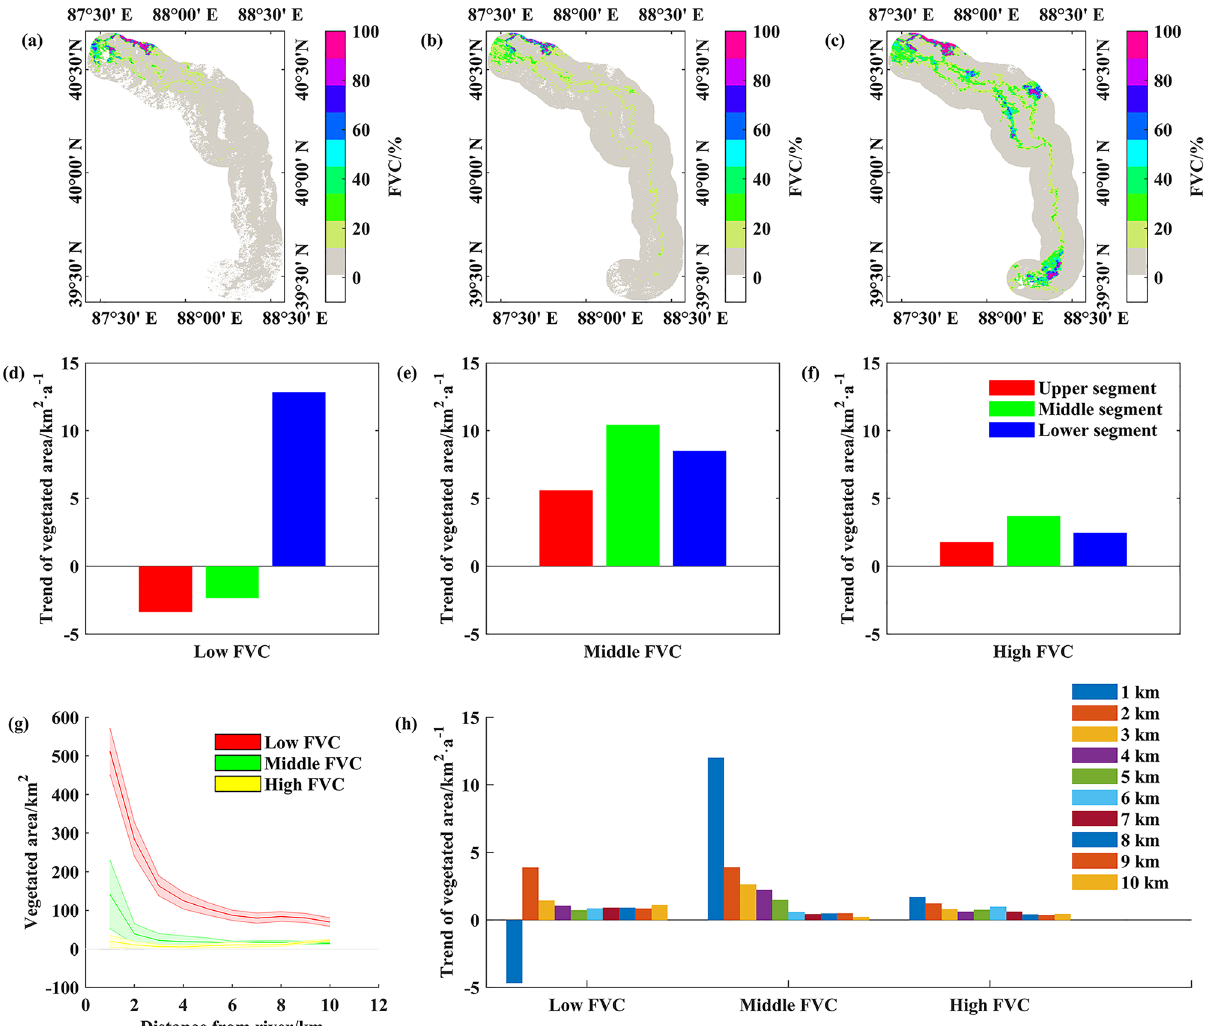
Figure 4. Variation of vegetation cover in the lower reaches of Tarim River. Spatial distribution of fraction of vegetation cover in ( a ) 2000, ( b ) 2010 and ( c ) 2020. Trends of ( d ) high fraction of vegetation cover, ( e ) middle fraction of vegetation cover and ( f ) low fraction of vegetation cover in different river sections. ( g ) Vegetation area and ( h ) change trend at different distances from the